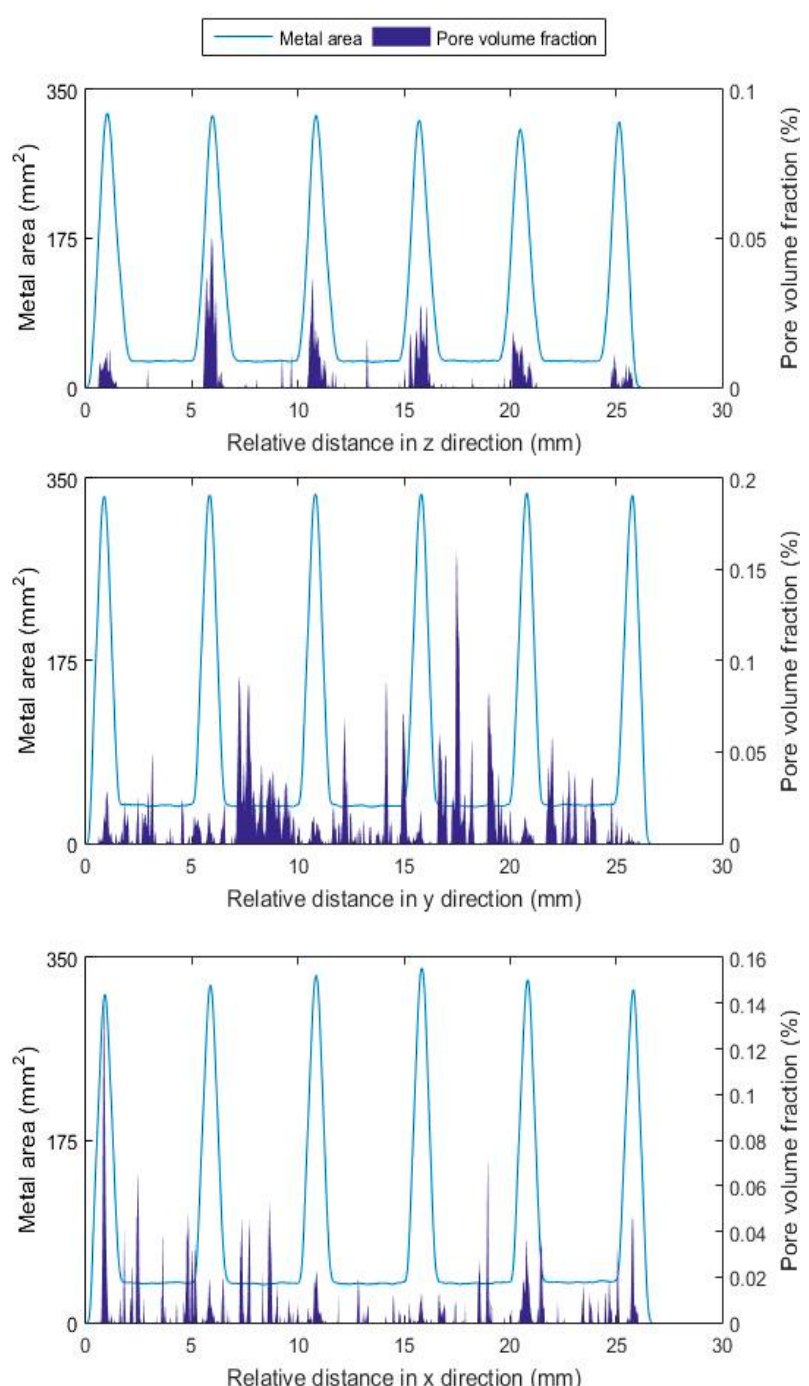
Figure 5. Metal area and pore fraction our slice with distance from the edge of the cubic sample. Top image shows the z direction parallel to the build direction, middle and bottom images the other two orthogonal directions.